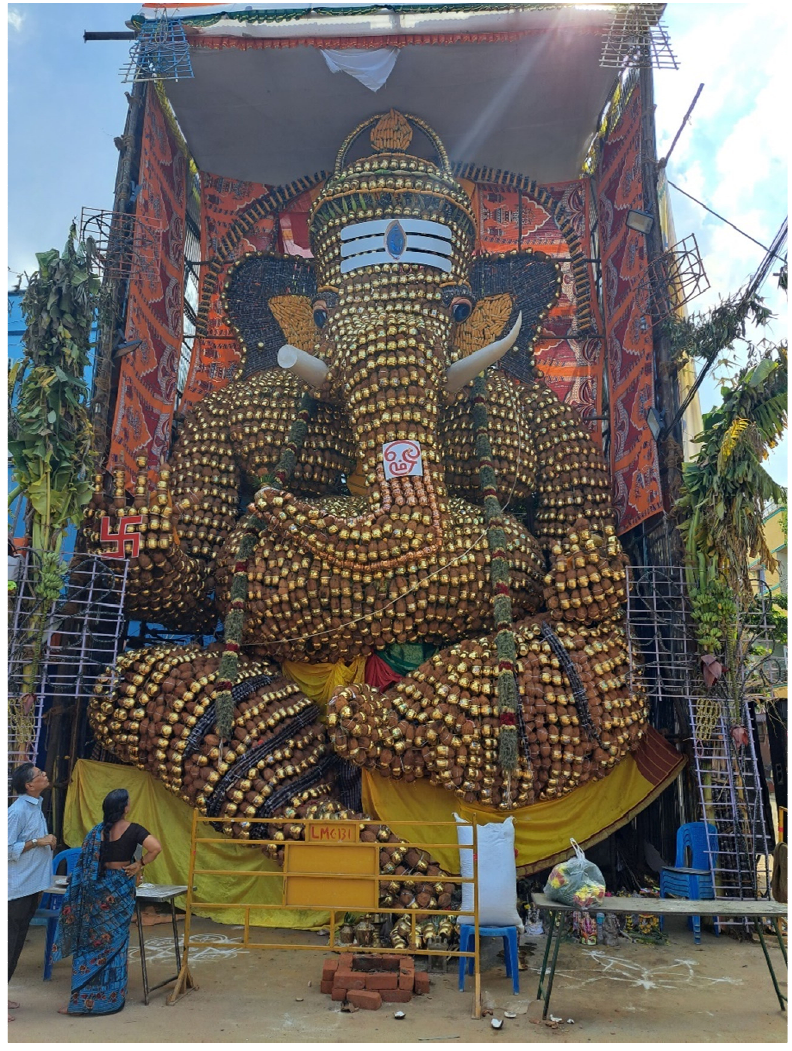
Figure 5. Ecofriendly metal pots and coconuts Ganesha in Kolathur sponsored by the Hindu Munnani. Picture taken by author, 3 September 2022,